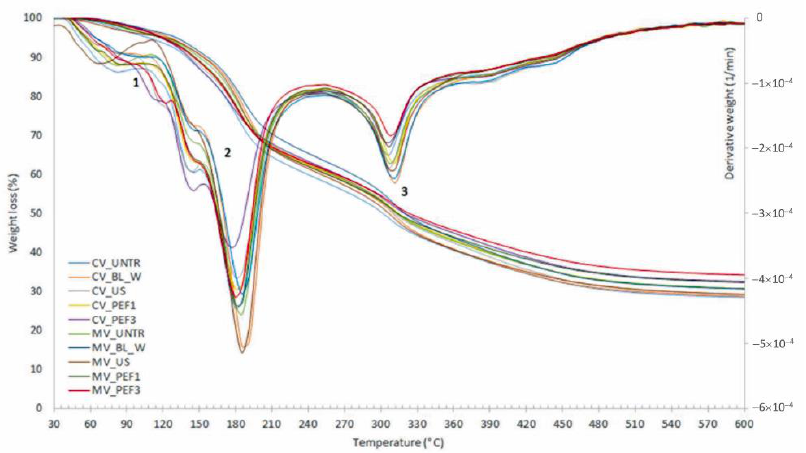
Figure 9. Phases of thermal degradation analysis (TGA and DTG) of convective (CV) and microwave– convective (MV) dried red bell pepper subjected to thermal or non-thermal treatment prior to drying.